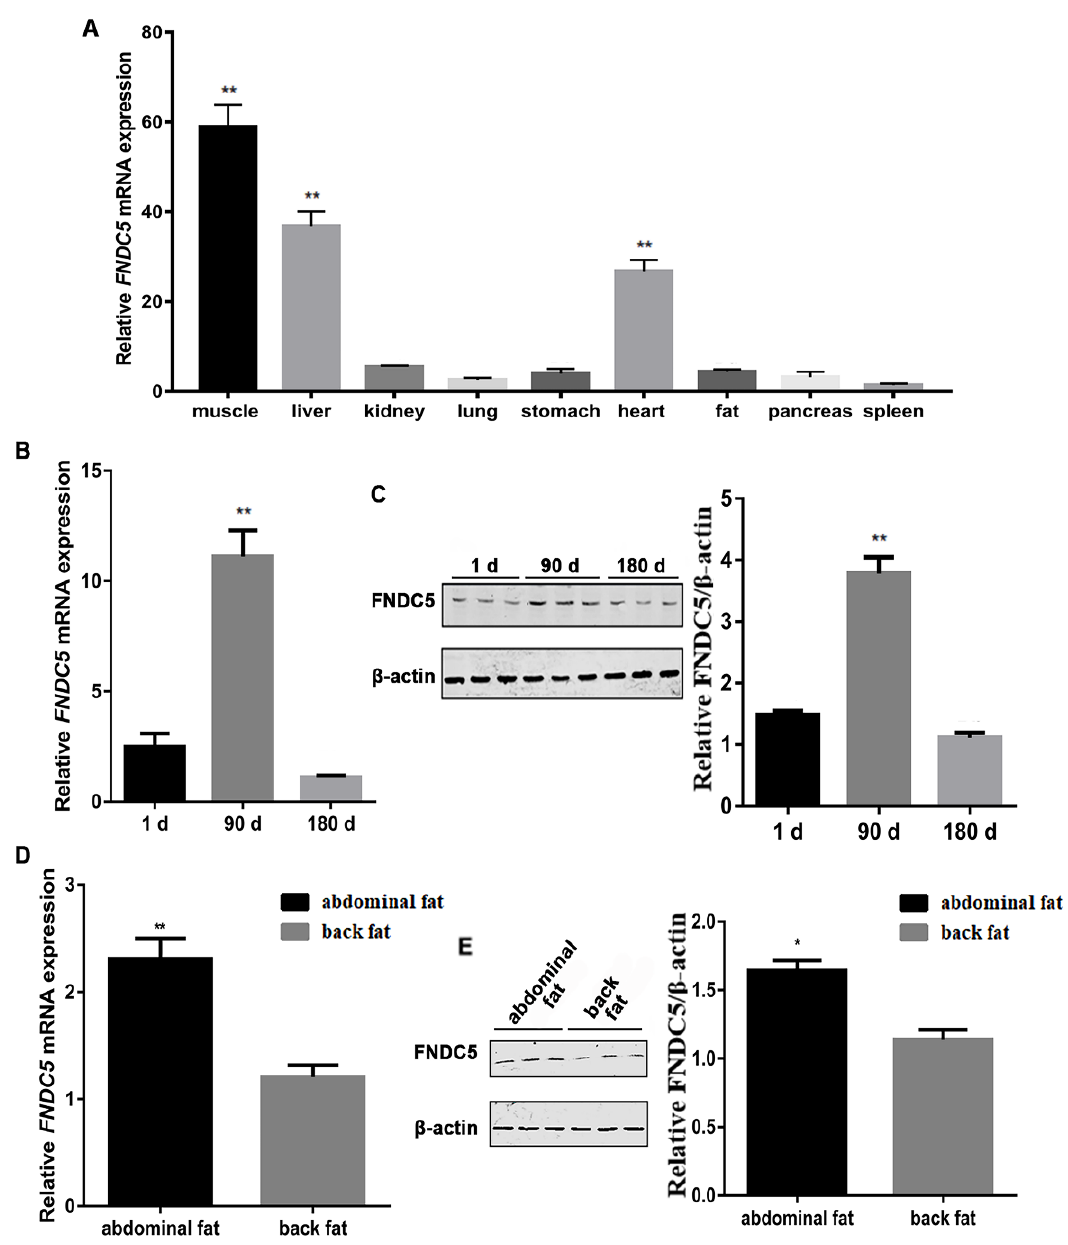
Figure 1. The expression profile of FNDC5 in Mashen pigs. ( A ) The expression of FNDC5 in different tissues of 90-day-old Mashen pigs. ( B , C ) The FNDC5 expression in back fat at 1, 90 and 180 days old by qRT-PCR and Western blotting. ( D , E ) The FNDC5 expression in abdominal and back fat in 90-day-old Mashen pigs. Notes: “**” means extremely significant difference ( p < 0.01) and “*” means significant difference ( p < 0.05).